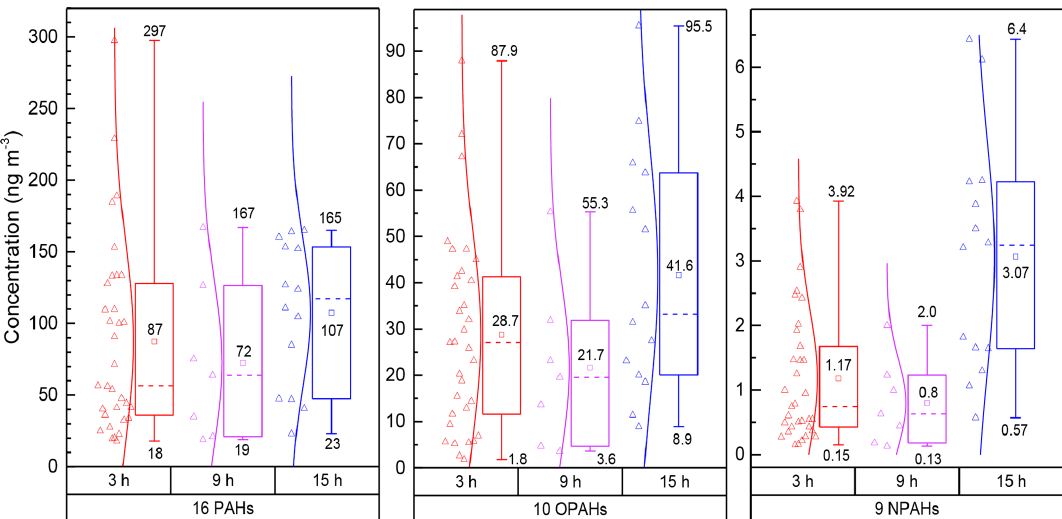
Figure 1. Concentrations of P PAHs, P OPAHs and P NPAHs in PM 2 . 5 samples during the daytime (3, 9h) and night-time (15h). The box plot represents the 25th and 75th percentiles range of the observed concentrations, and the bottom and top lines indicate minimum and maximum concentrations. Square symbols represent the mean concentration, and the short dashed line within the boxes represents the median. Empty triangles correspond to the data measured over 3, 9 and 15h samples. The lines between data points and boxes reflect a normal distribution